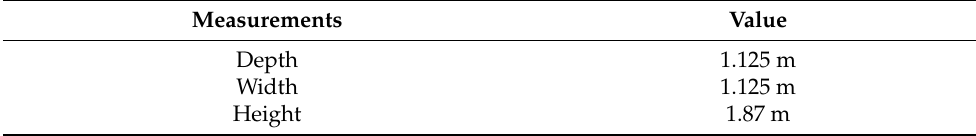
Table 5. Typical human dimensions and space requirements